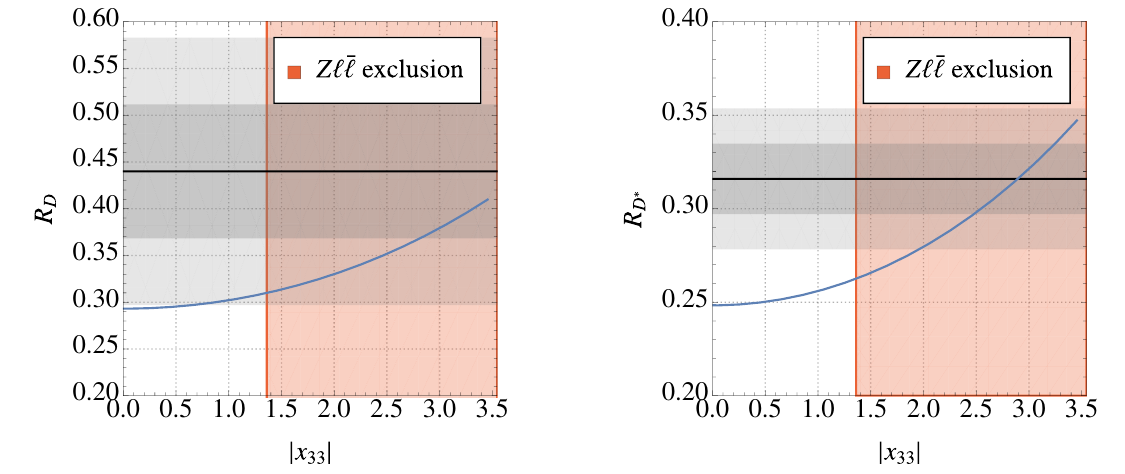
Figure 11. The solid blue lines represents the dependence of R (left) and R (right) on j x 33 j D D ( (cid:3) ) when all other couplings are set to zero and m = 1 TeV. A non-zero x 33 generates a small z 32 (cid:30) through the quark mixing of eq. (2.4), although the j x 33 j values required to meet the anomalies become large enough to dangerously modify the Z ! (cid:28)(cid:28) rate. The values of j x 33 j excluded by measurements of the Z(cid:28)(cid:28) coupling are shaded red. The solid black line represents the central values of the measurements for R and R , and the grey areas are the 1 and 2 (cid:27) D D ( (cid:3) )